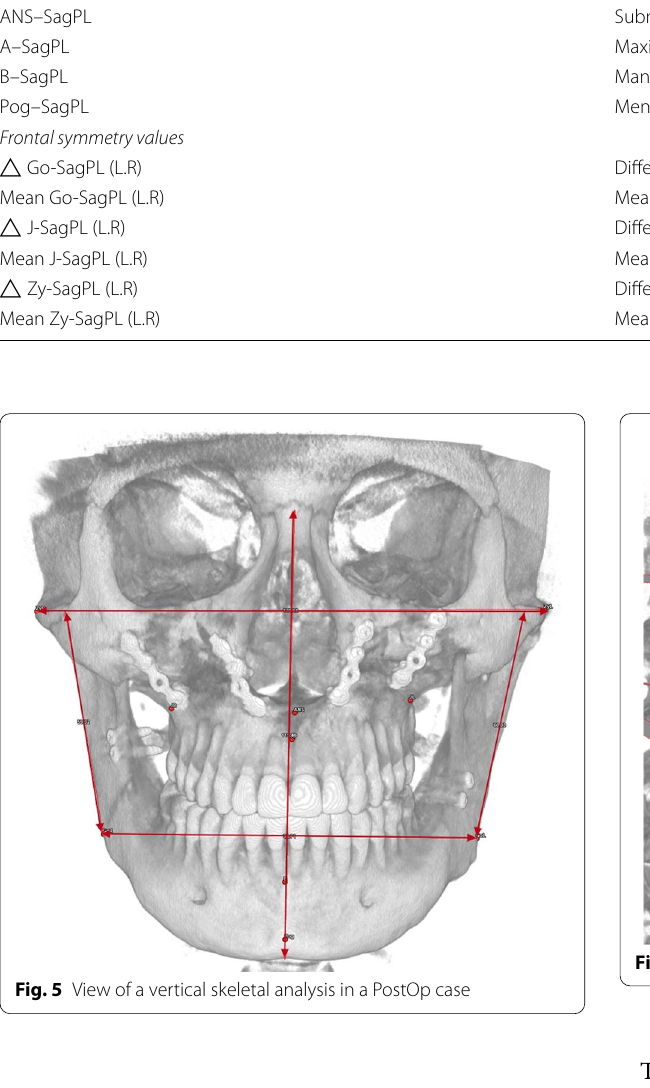
Table 6 Vertical skeletal analysis: vertical parameters and symmetry values Strictly vertical parameters Facial ratio Na-Me distance/Zy(L)-Zy(R) distance Mandibular ratio Co-Go distance/Go(R)-Go(L) distance Vertical symmetry values △ Md Ramus length (L.R)